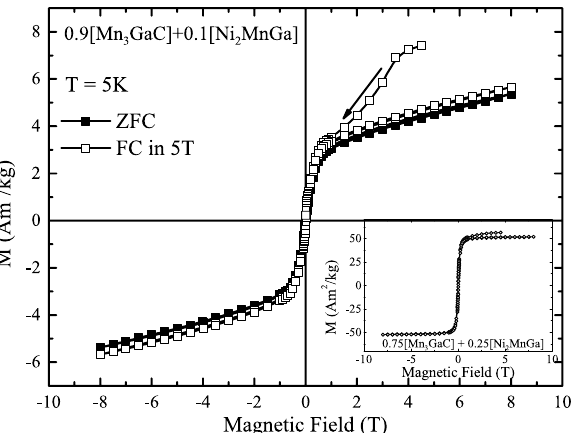
Figure 6. Field cooled (open squares) and zero field cooled (filled squares) hysteresis loop recorded at 5 K in 0.9 [Mn 3 GaC] + 0.1 [Ni 2 MnGa]. Inset shows FC hysteresis loops in 0.75 [Mn 3 GaC] + 0.25 [Ni 2